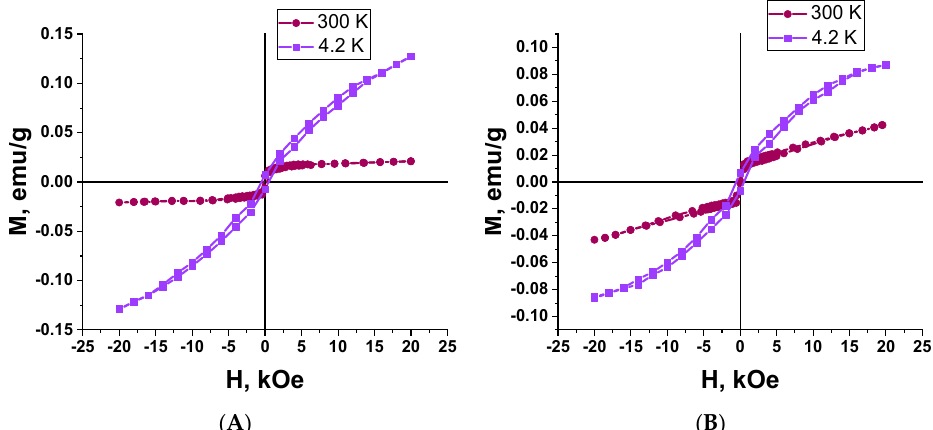
Figure 8. Comparison of the hysteresis loops for two samples of Ta 2 O 5 pillars with Ni tips at different temperatures: ( A )—sample 2 (type I), ( B )—sample 3 (type II).